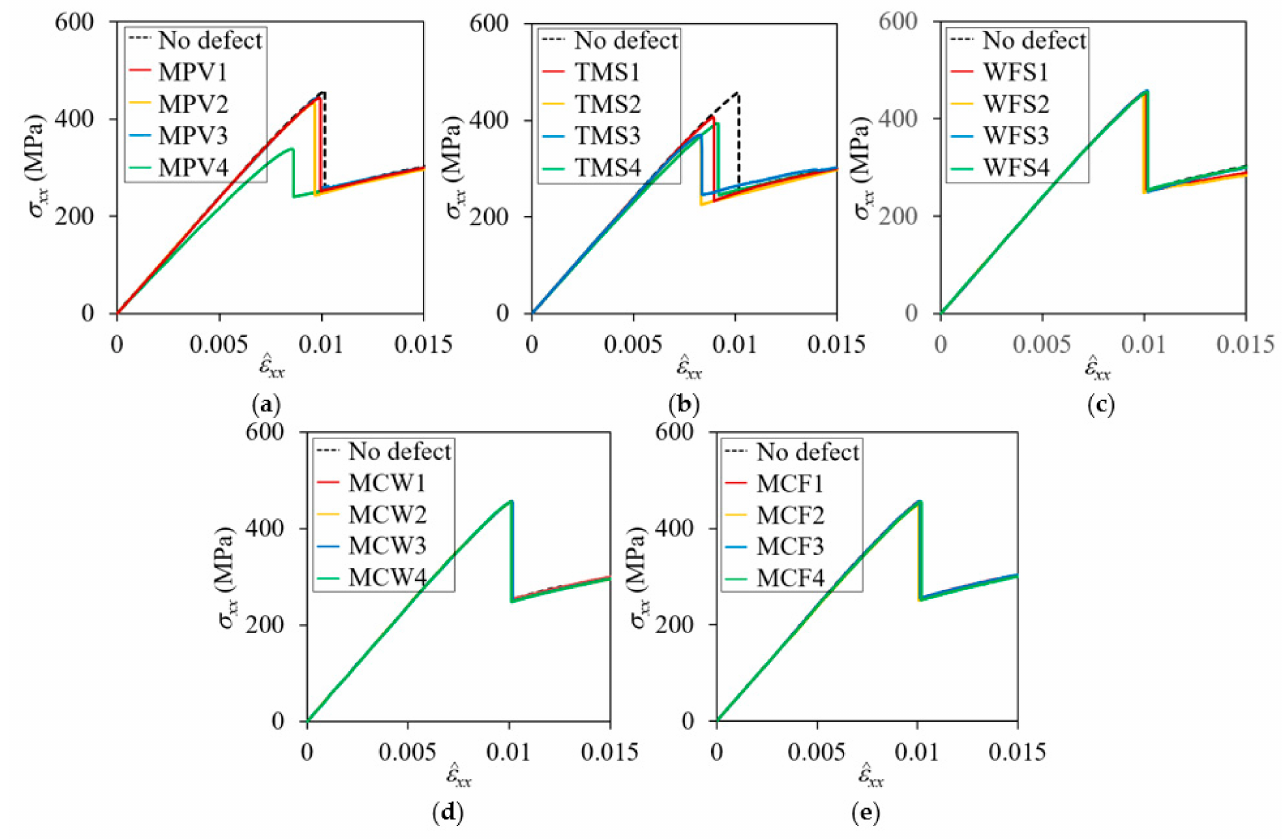
Figure 17. Effect of defects on nominal stress-strain curves for symmetric unit cell: ( a ) matrix pocket void; ( b ) tow and matrix pocket separation; ( c ) warp tow and fill tow separation; ( d ) matrix direction crack in warp tow; and ( e ) matrix direction crack in fill